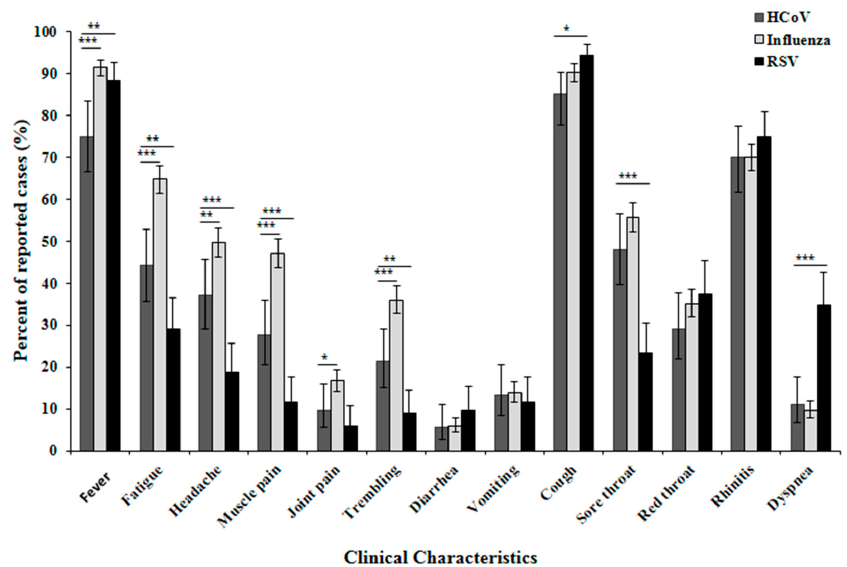
Figure 3. Clinical characteristics of patients infected with HCoV, RSV or influenza. A summary of the clinical symptoms of Israeli patients infected in the 2015–2016 winter season with HCoV, RSV or influenza. Confidence interval was calculated for the frequency of each symptom. */**/*** indicates p -